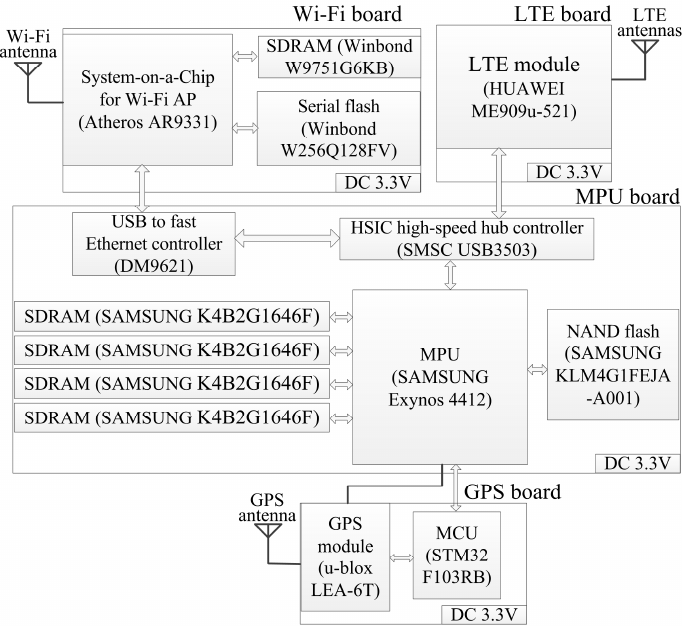
Figure 4. Schematic overview of gateway node structure.